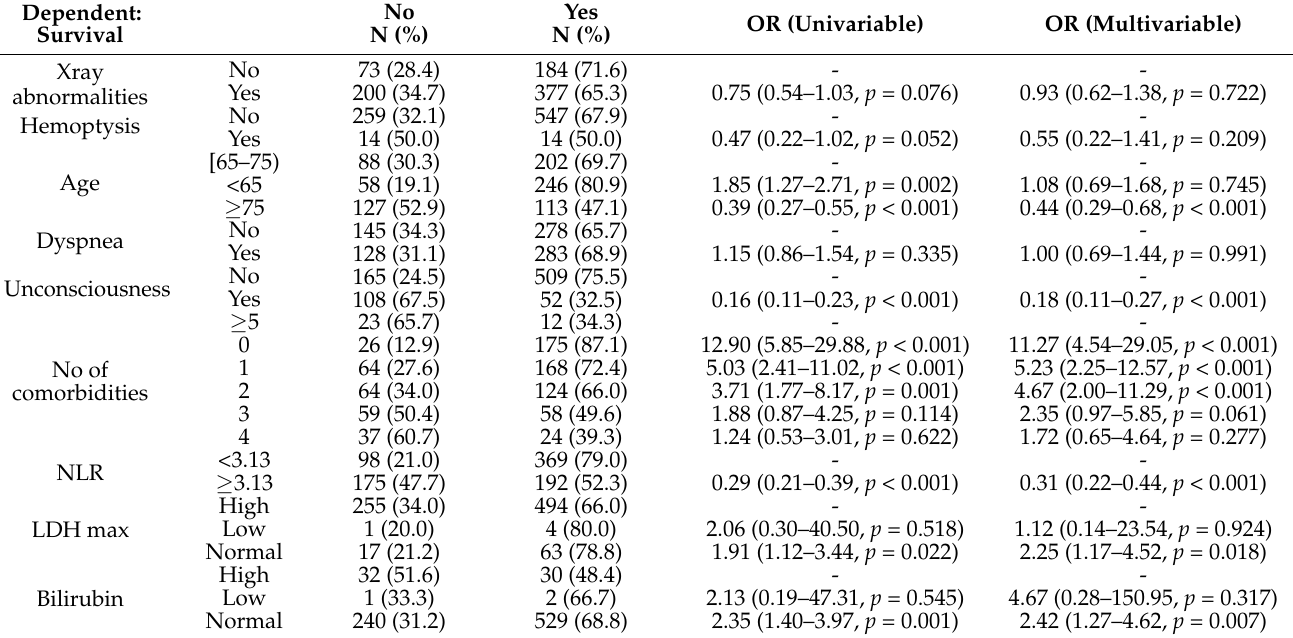
Table 7. Associations of individual GRAM score components with survival probability.